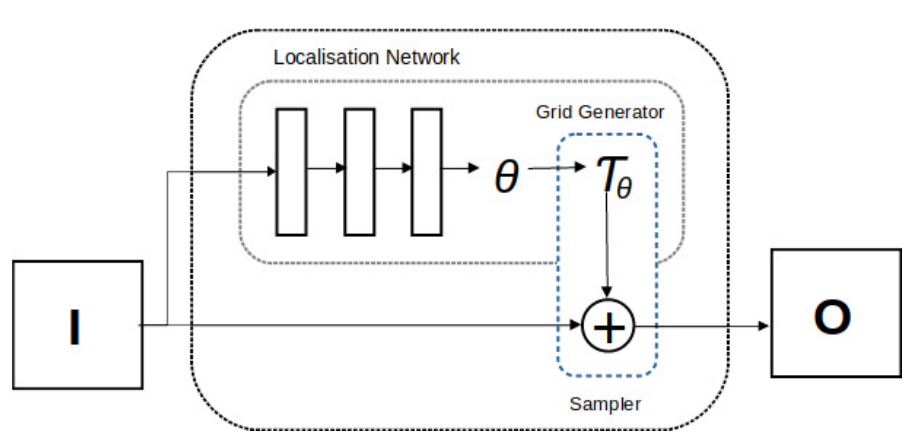
Fig. 4. A high-level overview of spatial transformer